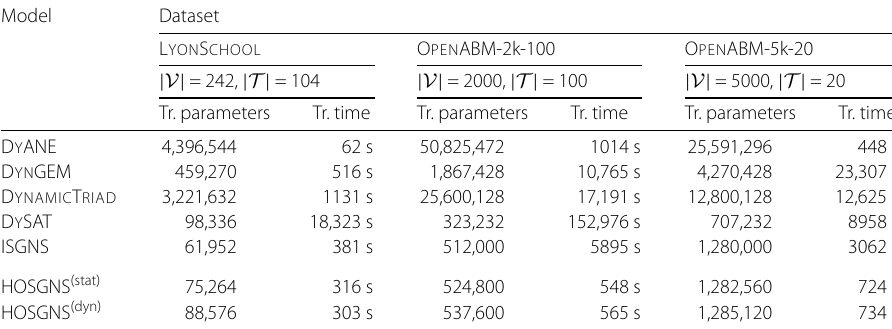
Table 7 Number of trainable parameters and training time of each time-varying graph representation learning model for L YON S CHOOL and the two synthetic datasets. The embedding dimension is fixed to 128, technical specifications of the computing system and hyper-parameters configuration are reported in Additional file